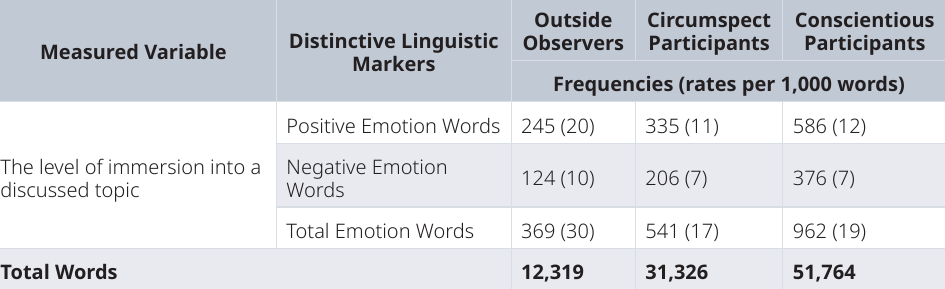
Table 4. Summary of the findings regarding the use of emotion words as indicating the level of teachers’ emotional immersion into a discussed